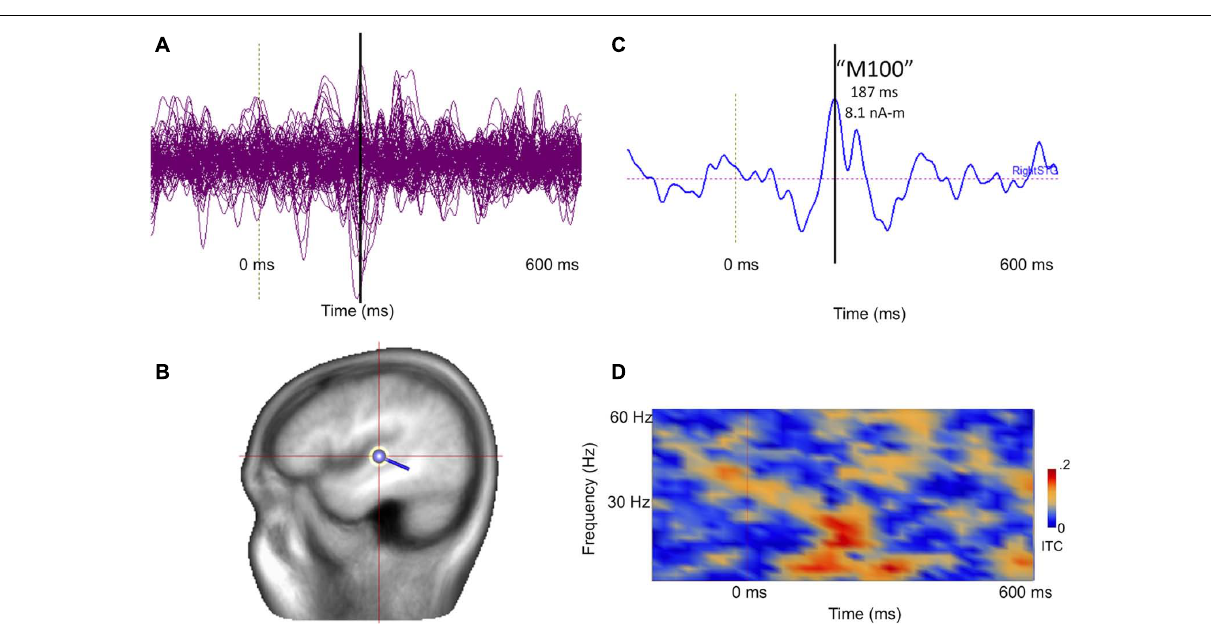
gyrus waveform, indicating a clear deflection at approximately 180 ms (vertical line). (D) Time-frequency transformation of the single–trial data allows estimation of inter-trial coherence (ITC), or phase-locking, for the source (time on x axis and frequency on y axis). Bright red regions post-stimulus indicate increased superior temporal gyrus phase-locking to the 1000 Hz tone, particularly at lower